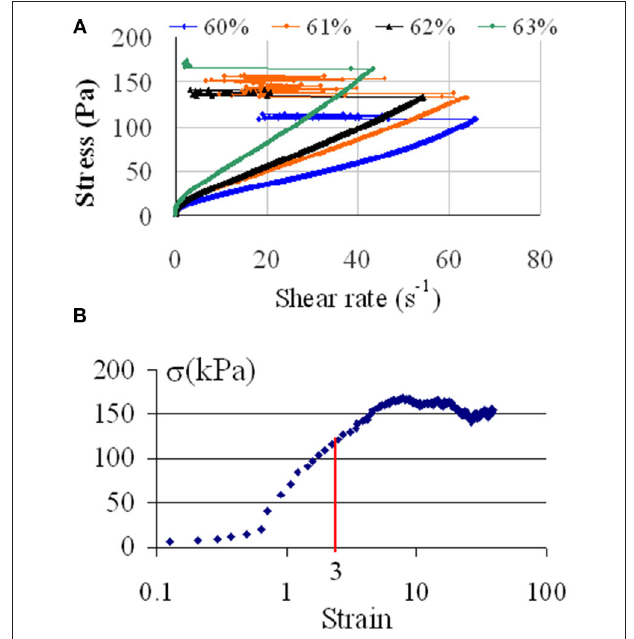
FIGURE 2 | (A) Rheogram of carbonyl iron suspensions with 0.2% of superplasticizer at high-volume fraction (blue:60%, orange 61%, black 62%,green 63%). (B) Stress vs. strain in cylindrical Couette geometry with vane tool, 8 0.61;H 0 19.2 kA/m, The vertical red line corresponds to a = = time of 2s where the shear rate has reached its final value of 1.6 s − 1 .